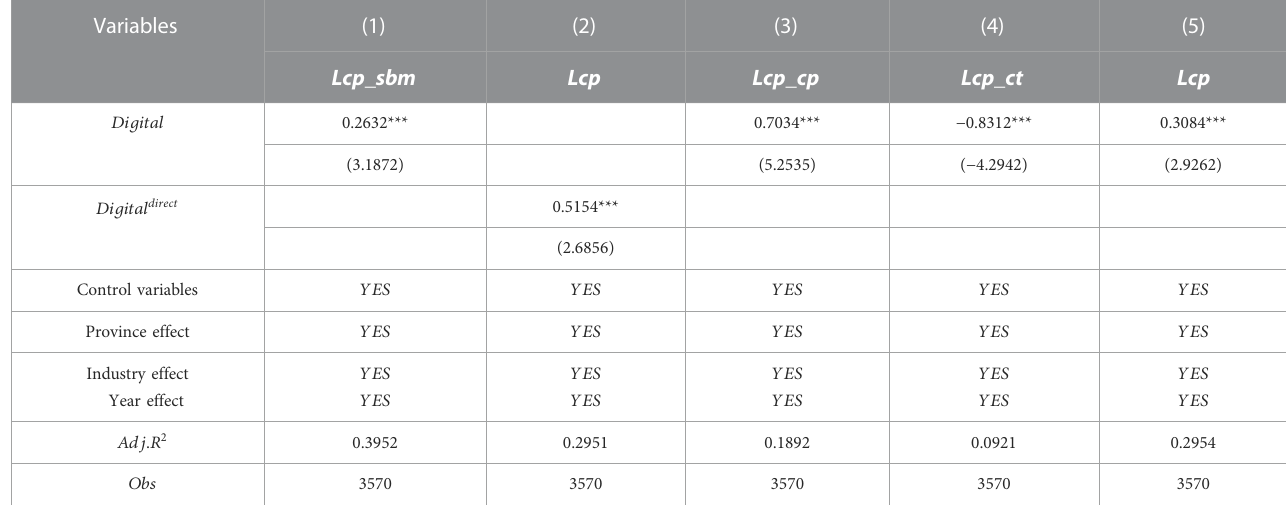
TABLE 6 Results of stability